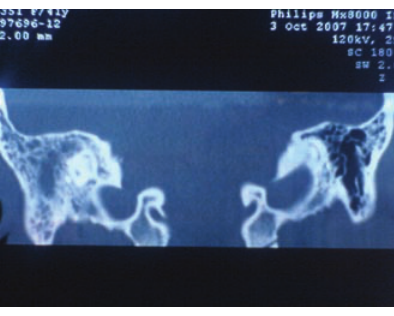
Figure 11. Right mastoiditis (CT scan- coronal projection). The patient under- went cortical mastoidectomy.